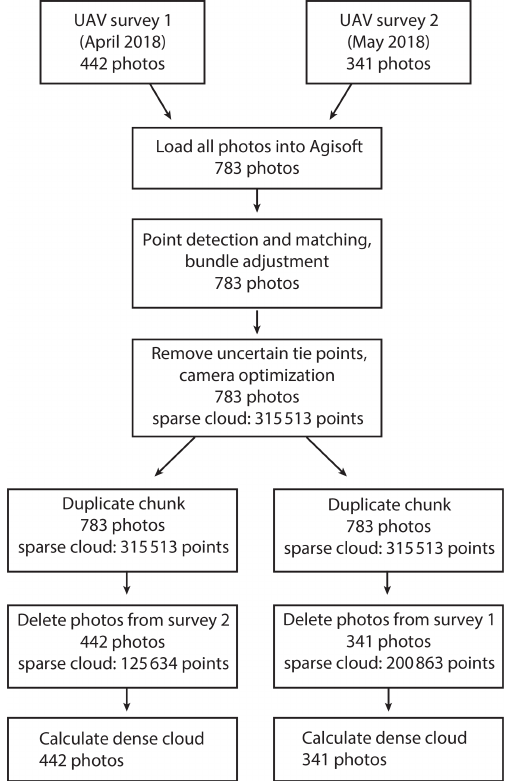
Figure 2. Workflow of the co-alignment processing method, with numbers from the April–May 2018 Rügen Kieler Bach comparison for